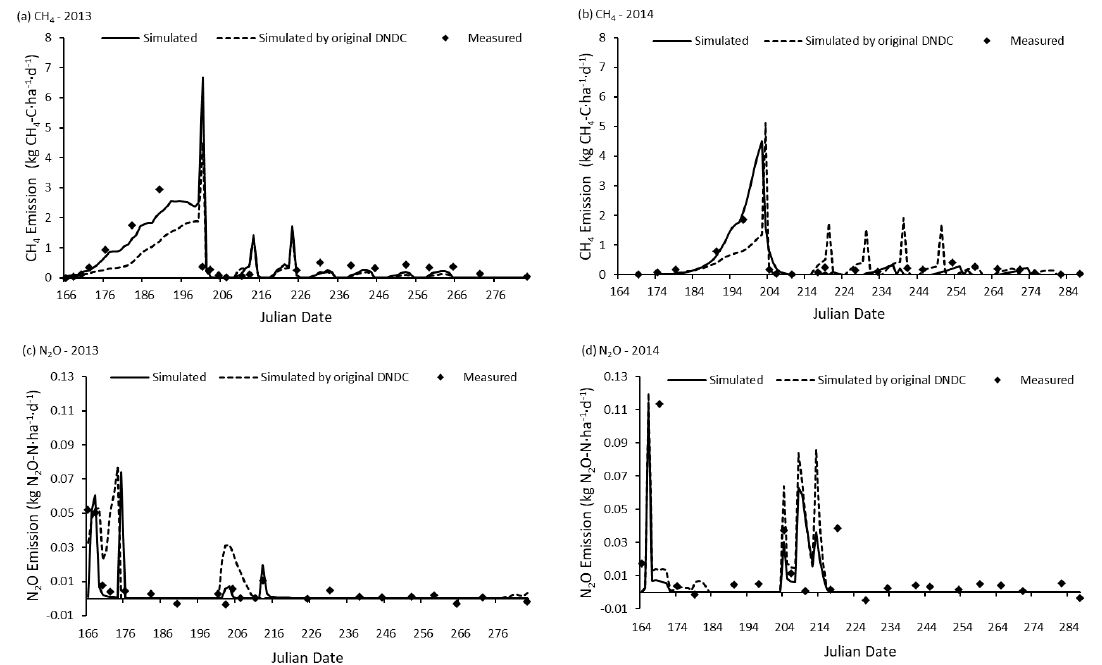
Figure 6. Comparison between simulated and measured value of daily CH 4 and N 2 O emissions [22].